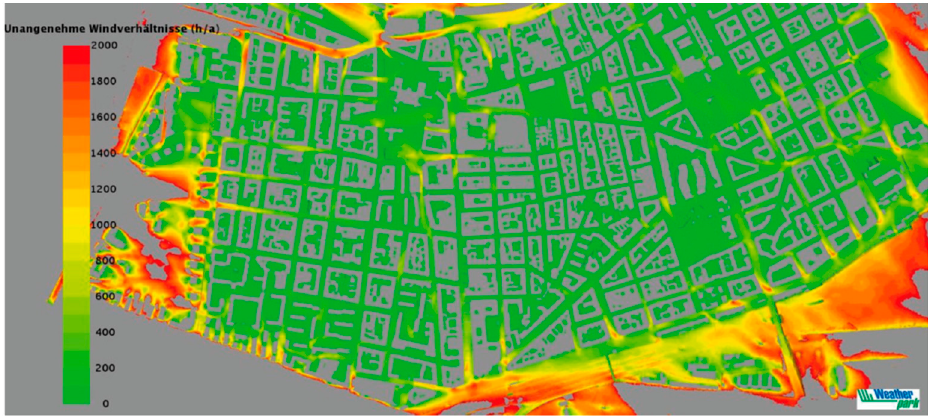
Figure 5. Number of hours per year (in the map’s legend abbreviated as “h/a” (hours per annum)) with uncomfortable wind